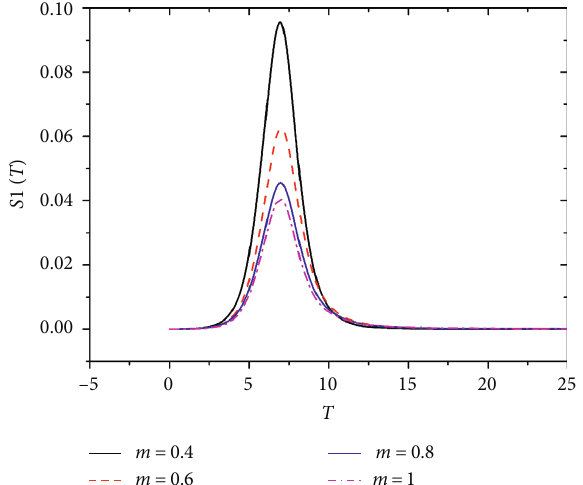
Figure 3: Density of spreader1 over time for different values of m .